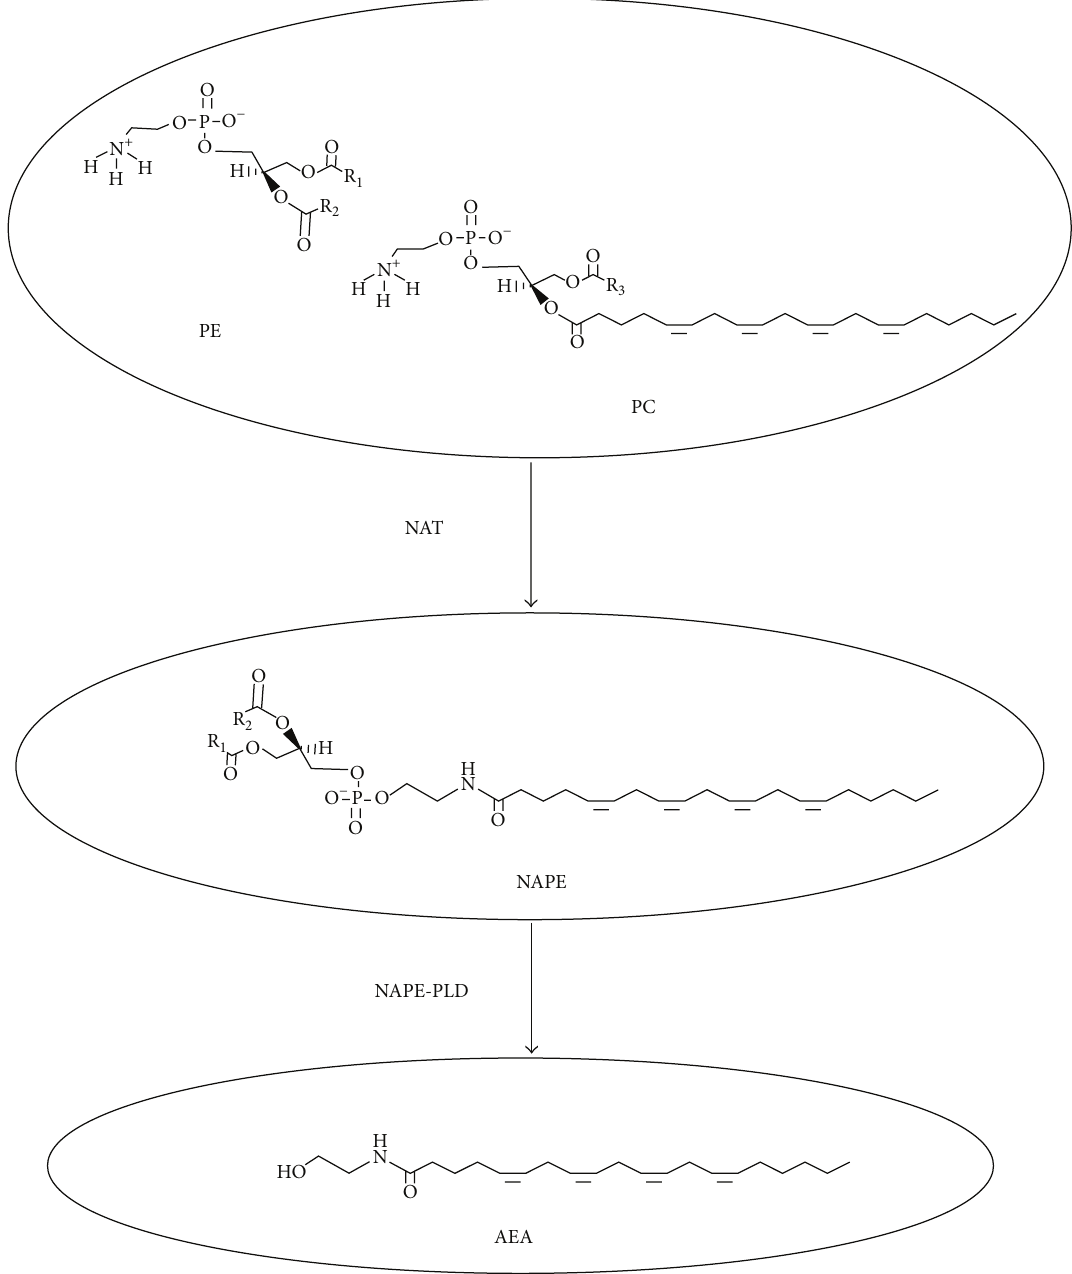
Figure 1: Synthesis of N -arachidonoylethanolamine (AEA). N -acyltransferase (NAT) catalyzes the transfer of arachidonic acid (AA) from phosphatidylcholine (PC) to phosphatidylethanolamine (PE) to form N -arachidonoyl-phosphatidylethanolamine (NAPE). NAPE is then converted into AEA in a one-step hydrolysis reaction catalyzed by the NAPE-specific phospholipase D